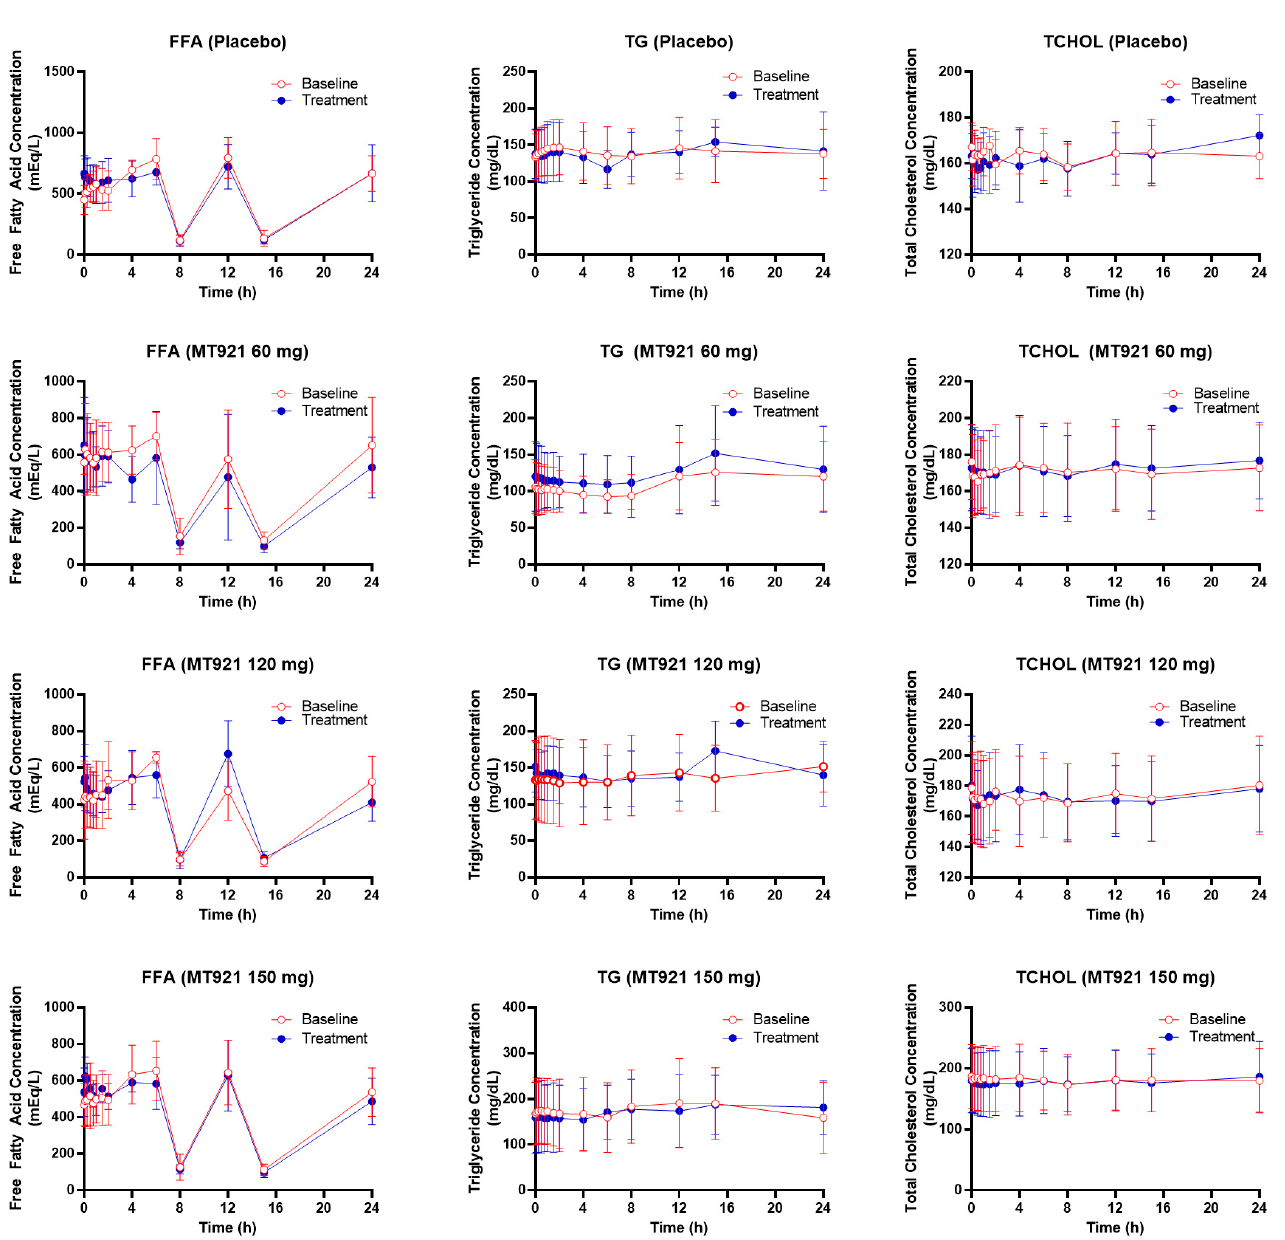
Figure 4. Mean plasma concentration-time profile of free fatty acid (FFA), triglyceride (TG), and total cholesterol (TCHOL) before and after administration of MT921.